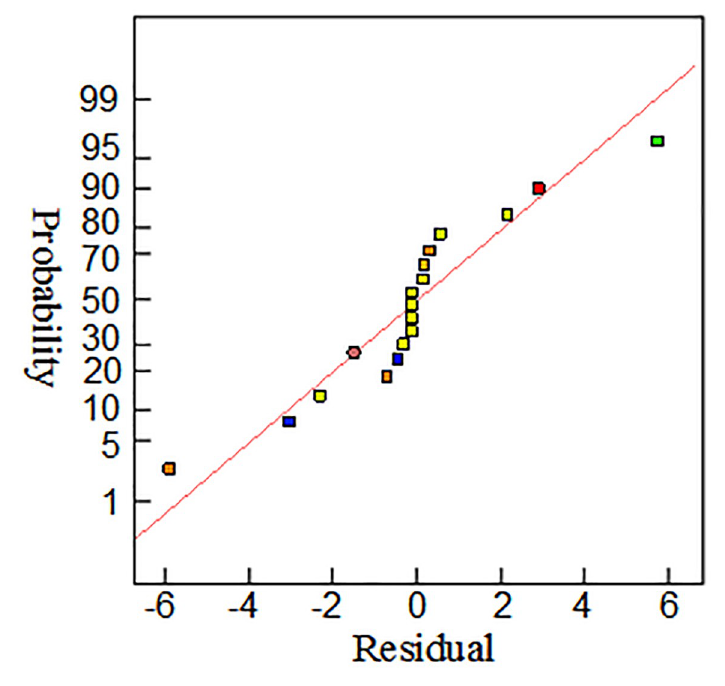
Fig 10. Probability graph of residual normal